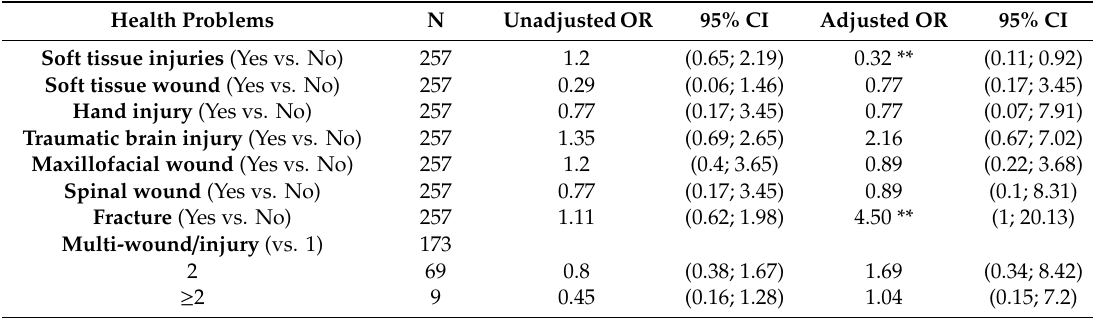
Table 3. Factors associated with Kessler score and having psychological